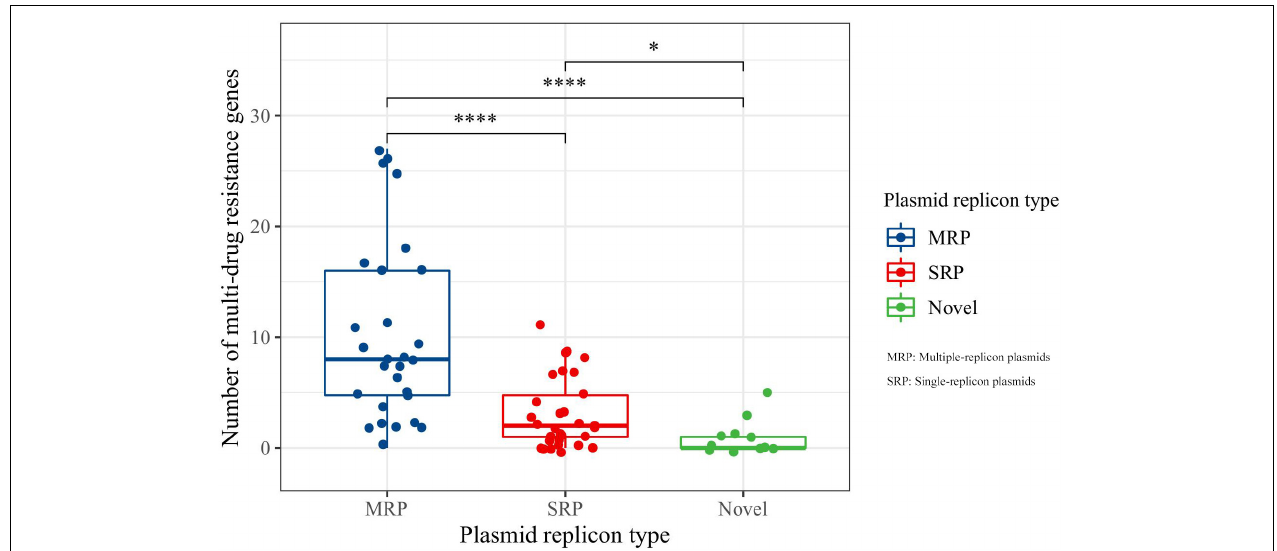
FIGURE 2 | Comparative analysis of antimicrobial resistance genes carried by plasmids. MRP indicates multiple-replicon plasmid; SRP indicates single-replicon plasmid. *Indicates significant difference, ****indicates extremely significant difference.